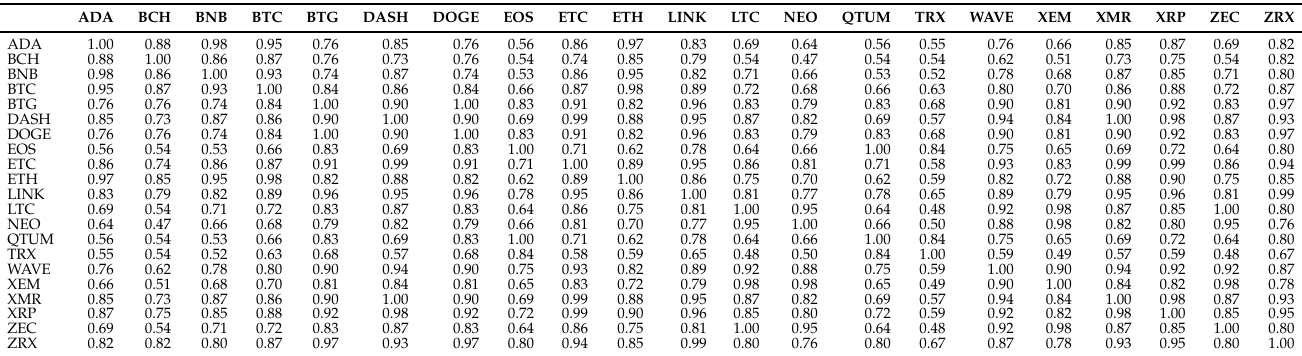
Table 6. Correlations among cryptocurrencies. Class Downtrend.